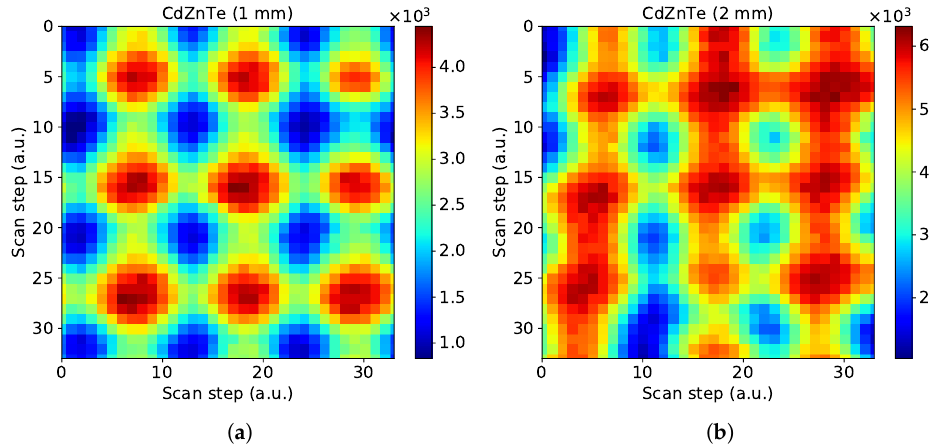
Figure 7. Sensitivity maps of a 3 × 3-pixel area within CdZnTe sensors with 55 µm pixel pitch and a thickness of ( a ) 1 mm and ( b ) 2 mm. The raster scans performed with a step of 5 µm with the energy threshold set at 5